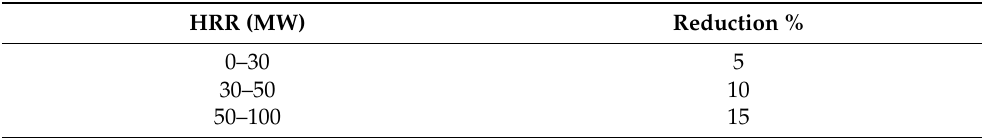
Table 3. Basic recognition time reduction for various HRR range.